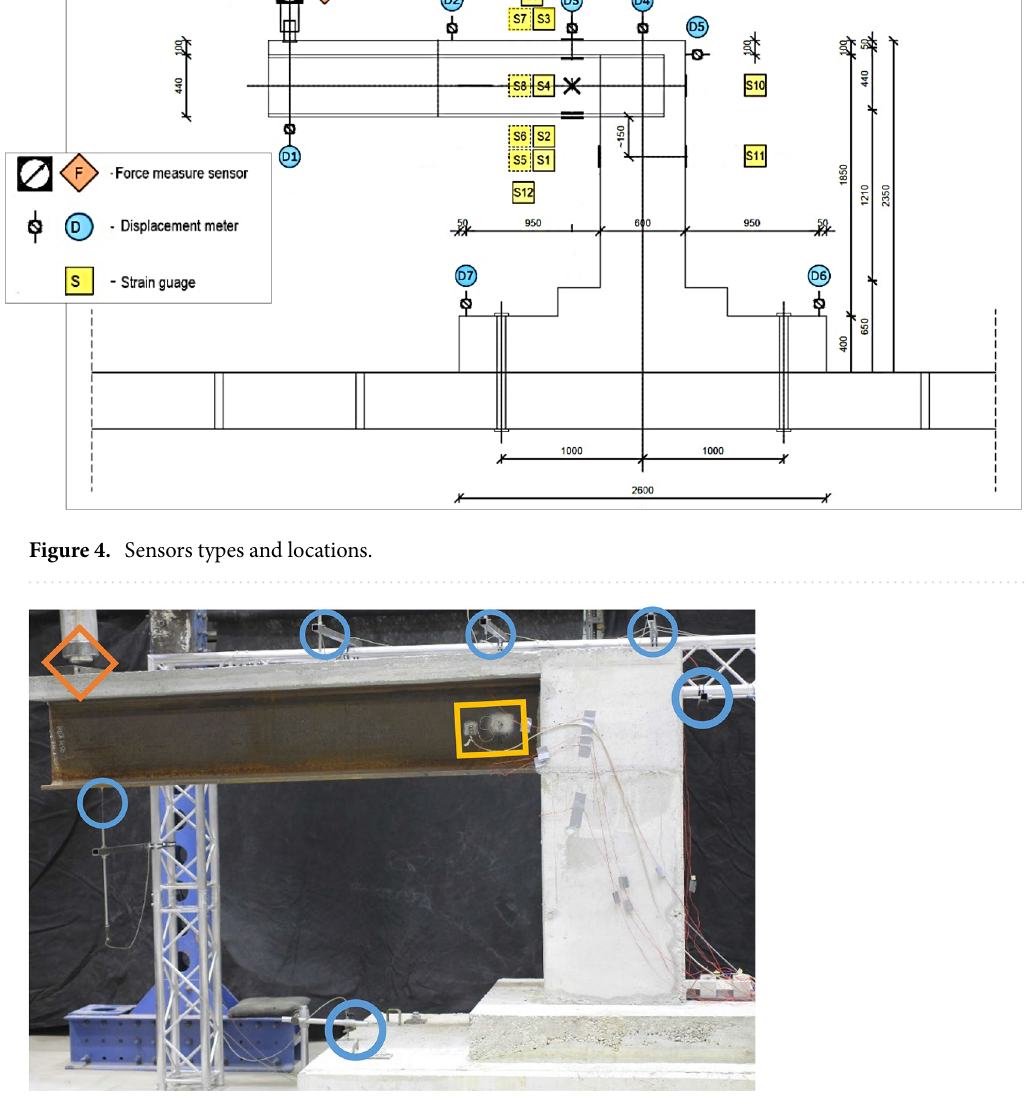
Figure 5. Sensors Installation during the experiments